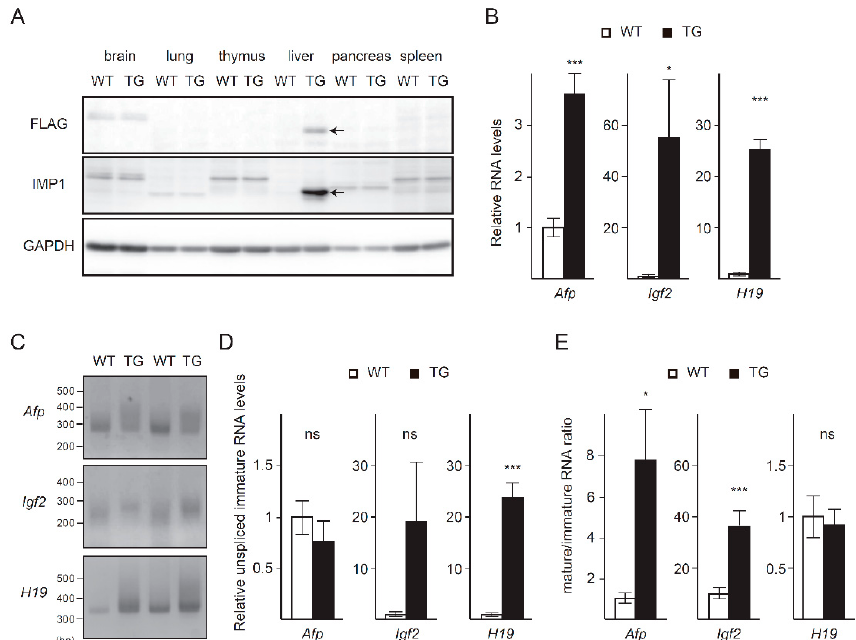
Figure 4. Mice exogenously expressing IMP1 in adult liver show higher expression and longer poly(A) tails of fetal liver transcripts. ( A ) Immunoblot of the indicated molecules in tissues from 4 w wild-type (WT) and Imp1 -transgenic (TG) mice. ( B ) qPCR analysis of the indicated transcripts in livers from 4 w wild-type and Imp1 -TG mice ( n = 8). Gapdh mRNA levels were used for normalization. ( C ) Comparison of poly(A) tail lengths of the indicated transcripts in livers from 4 w WT and Imp1 -TG mice. ( D ) qPCR analysis of unspliced immature transcripts of fetal liver genes in livers from 4 w WT and Imp1 -TG mice ( n = 8). Gapdh mRNA levels were used for normalization. ( E ) Mature/unspliced immature transcript ratios were calculated using the results in ( B ) and ( D ). Levels in WT mice are set to 1. Values in graphs represent means ± sem. * p < 0.05, *** p < 0.001. ns (not significant).